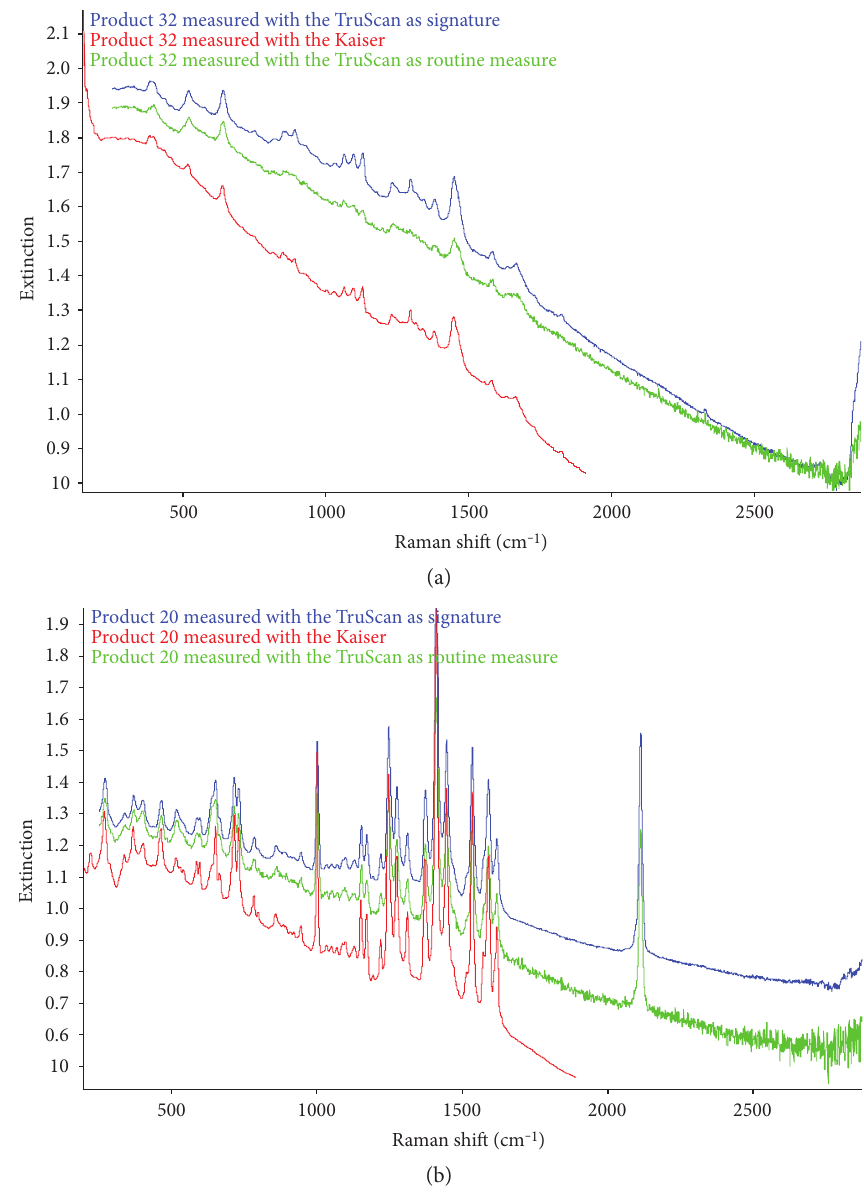
Figure 6: Overlay of Raman spectra obtained with the TruScan Thermo® (signature and routine measure) and the RXN1 Kaiser Optical Systems® devices for product 32 capsule (a) and product 20 tablet